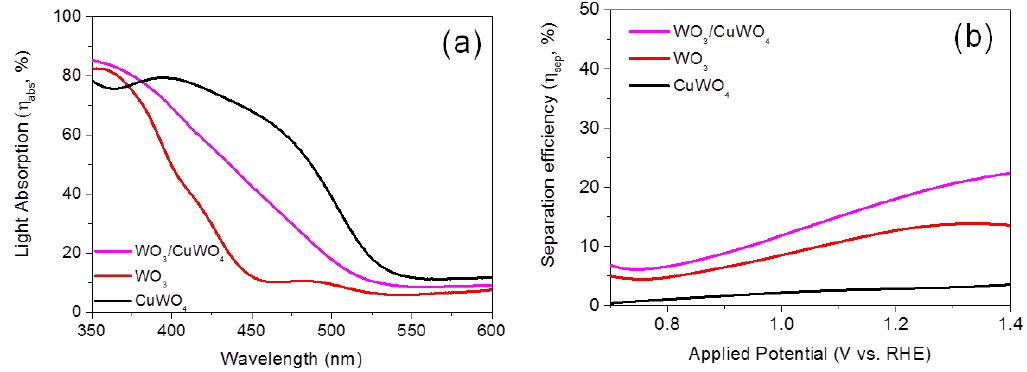
Figure 5. ( a ) Light absorption efficiency of WO 3 , CuWO 4 and WO 3 /CuWO 4 films obtained from an integrating sphere; ( b ) Charge separation efficiency of WO 3 , CuWO 4 and WO 3 /CuWO 4